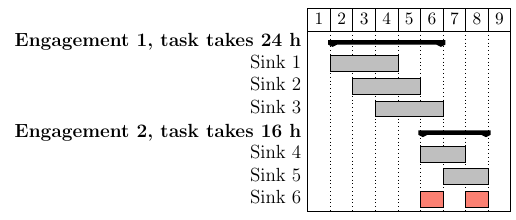
Fig. 4 Availability of each engagement in days is depicted by the black ranges. Possible sinks, assuming that auditor a can work 8 h every day, are represented by gray rectangles. Sinks 3 and 4 cannot be assigned to auditor a because of the overlap. However, sinks 2 and 4 can be assigned to auditor a because no overlap occurs. An example of an illegal sink is sink 6, because once an auditor starts working on an engagement, the auditor must finish it as soon as